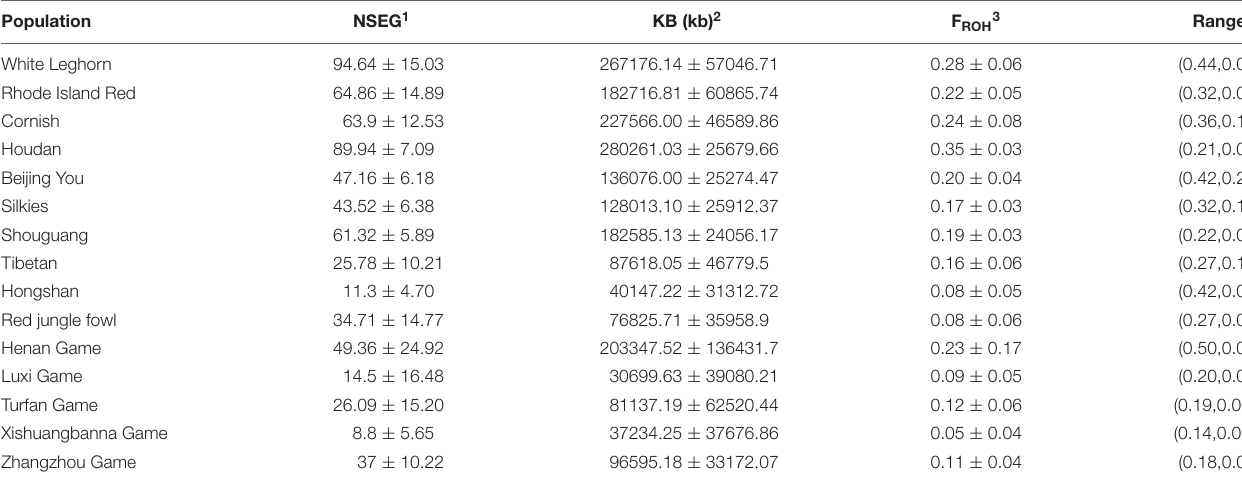
TABLE 3 | Statistical for runs of homozygosity and genomic inbreeding coefficient in different type breeds.